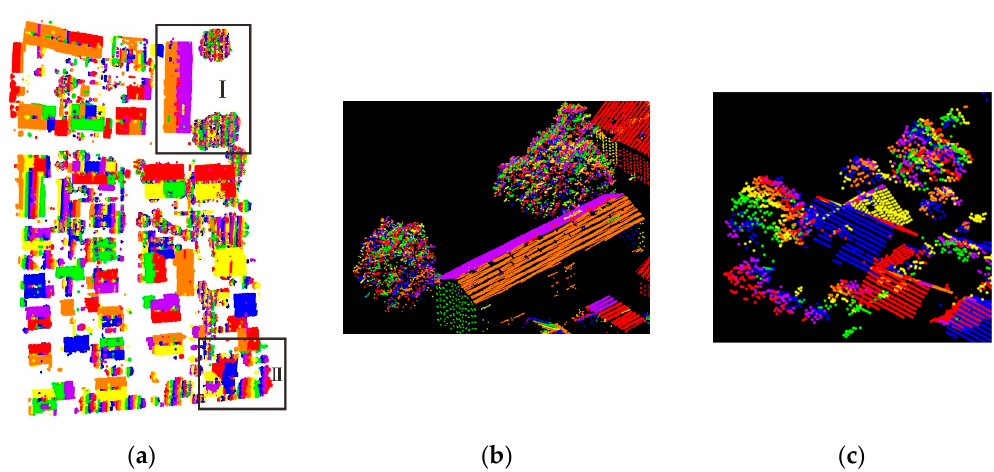
Figure 2. Graph segmentation based on multi-constraints. ( a ) The result of graph segmentation based on multi-constraints; ( b ) enlarged version of the area I in ( a ); ( c ) enlarged version of the area II in ( a ). The colors are assigned randomly according to different segmentation objects. Different colors represent different segmentation objects.